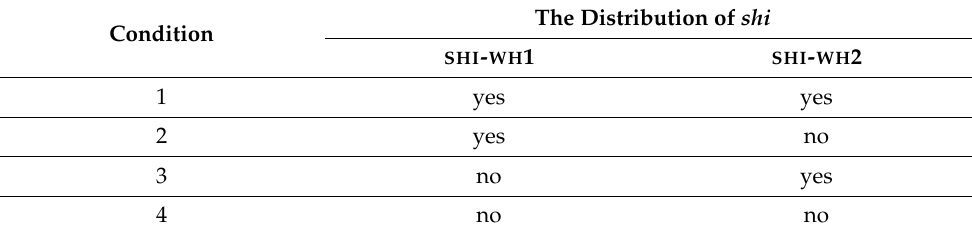
Table 3. The distribution of shi in each test